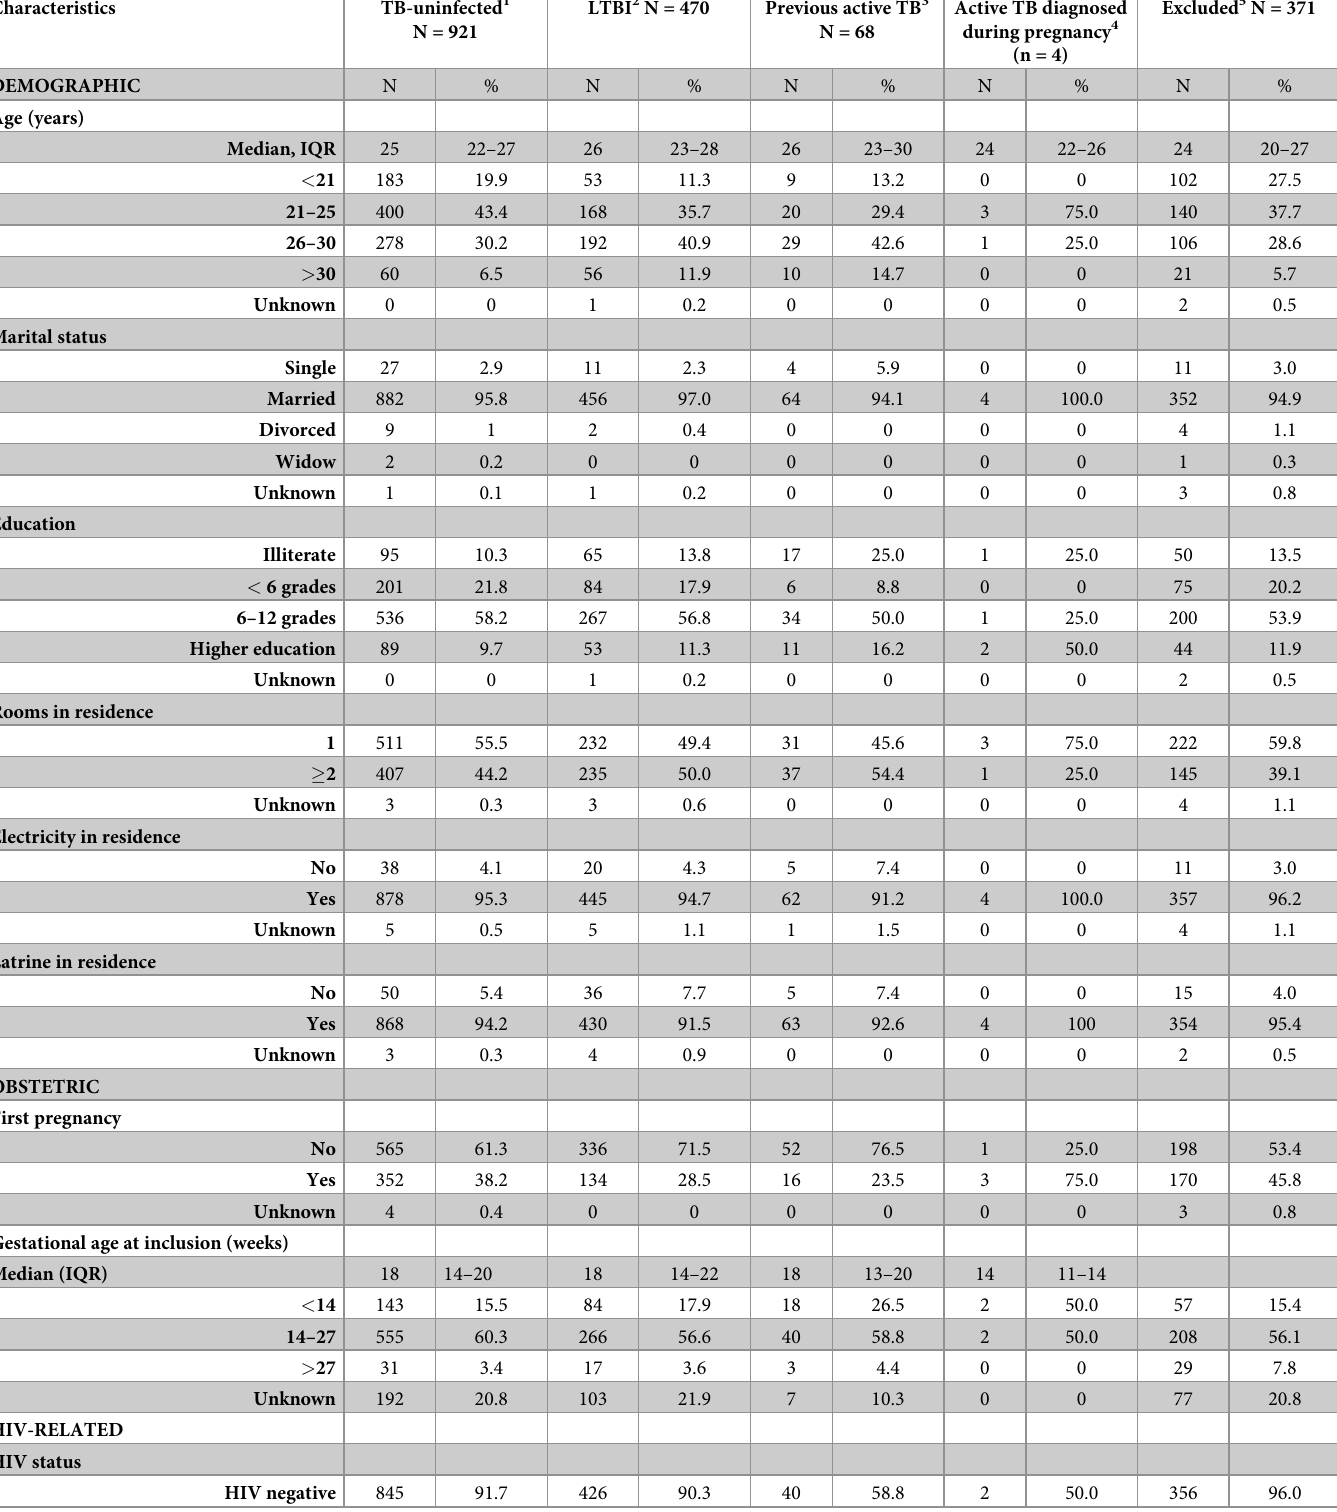
Table 1. Study participant characteristics and pregnancy outcomes by TB infection status.